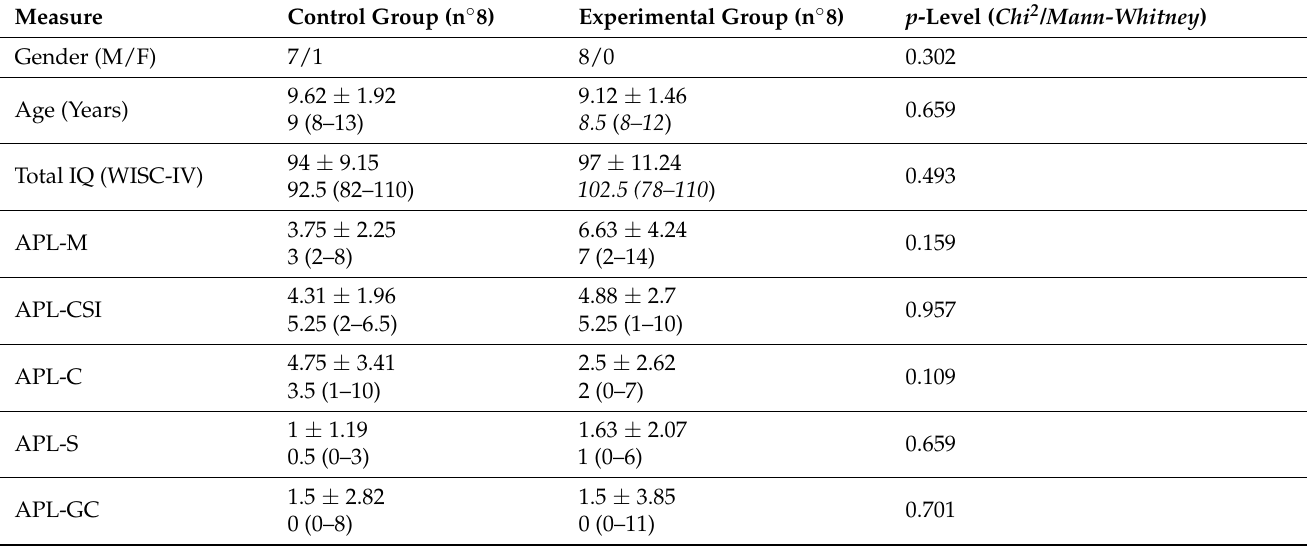
Table 4. Demographic characteristics of children with ASD.